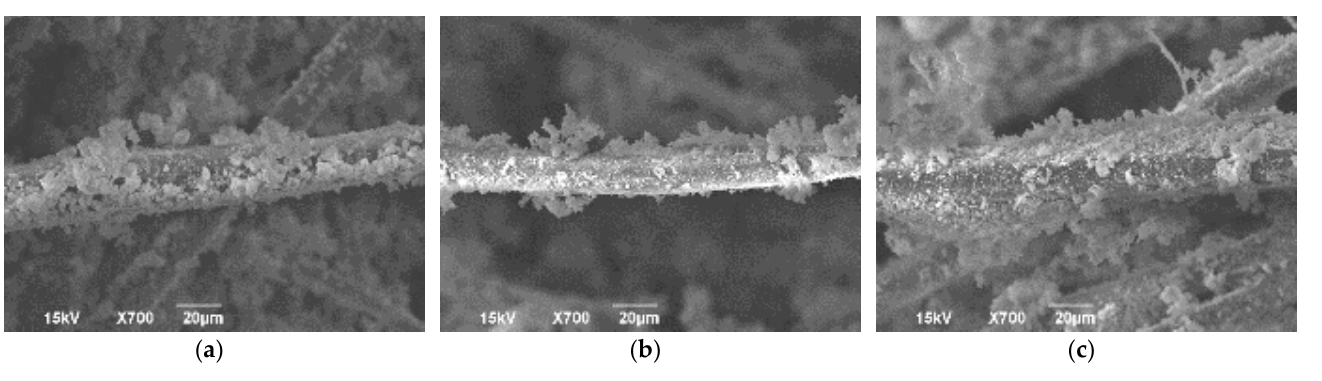
Figure 12. SEM images of ( a ) nanosilica particle agglomerates, ( b ) 30% STF flax, ( c ) 50% STF flax, ( d ) 70% STF flax.